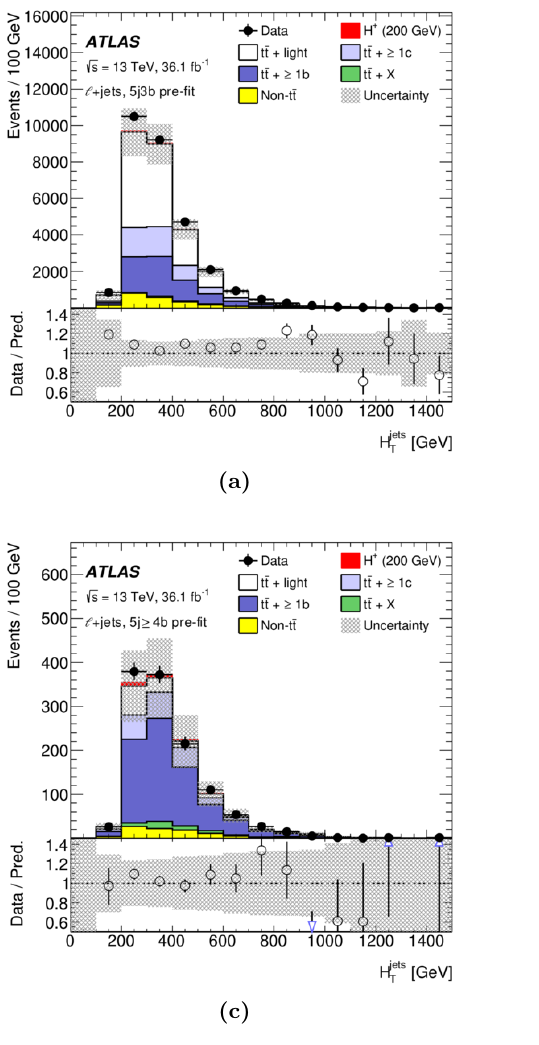
Figure 3. Distributions of the H jets T channel: (a) 5j3b, (b) (cid:21) 6j3b, (c) 5j (cid:21) 4b, (d) (cid:21) 6j (cid:21) 4b. Each background process is normalised accord-